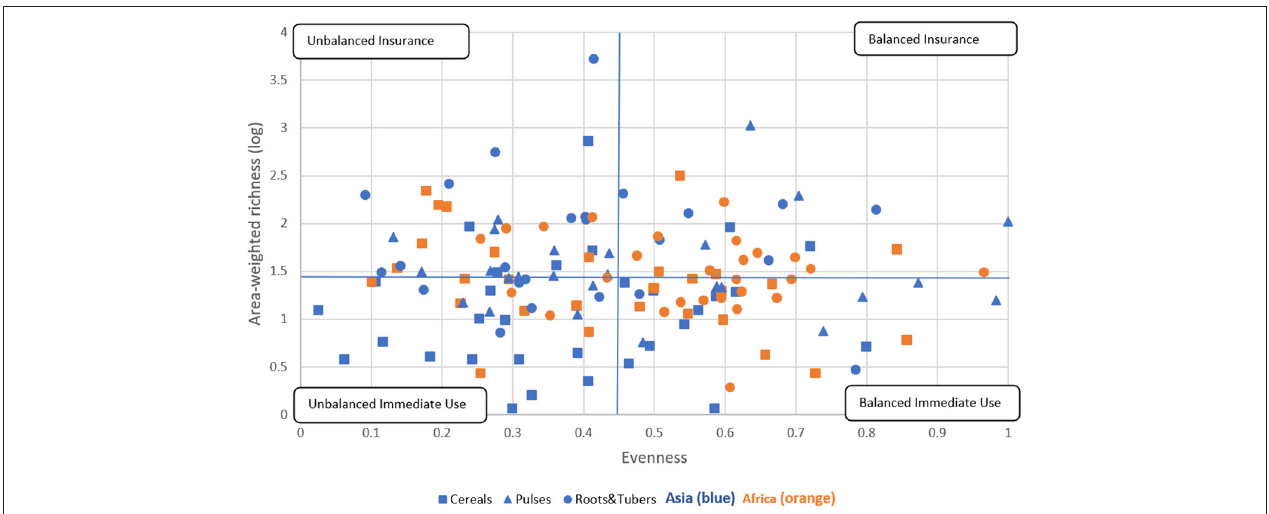
FIGURE 6 | Crop diversity framework—an application. This framework allows comparision of the relative diversity of cereal, pulse, and root and tuber crop varieties in Asia and Africa using all 137 crop-country-combiations. Four quadrants are established using the combination of total mean values of area-weighted richness (1.43) and evenness (0.45). Diversity categories are described in Figure 1 . The cropping systems are independently distributed, as the Chi-square test reveals across regions and diversity category ( P < 0.005) and across crop group and diversity category ( P < 0.009) (see Supplementary Tables 3, 4